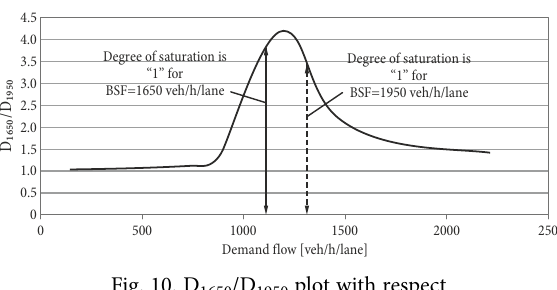
Degree of saturation is “1”